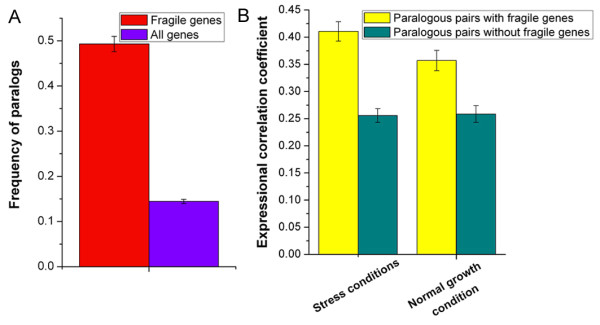
Backup mechanisms used for fragile genes. (A) Frequency of paralogs is shown for fragile genes (red) and all genes (violet). (B) Pair-wise Pearson correlation coefficient in expression profiles was calculated for each paralogous gene pairs under both stress and normal growth conditions. Average values that correspond to expressional correlation coefficient are shown for paralogous pairs with fragile genes (yellow) and paralogous pairs without fragile genes (dark cyan). Error bars were calculated by bootstrapping.